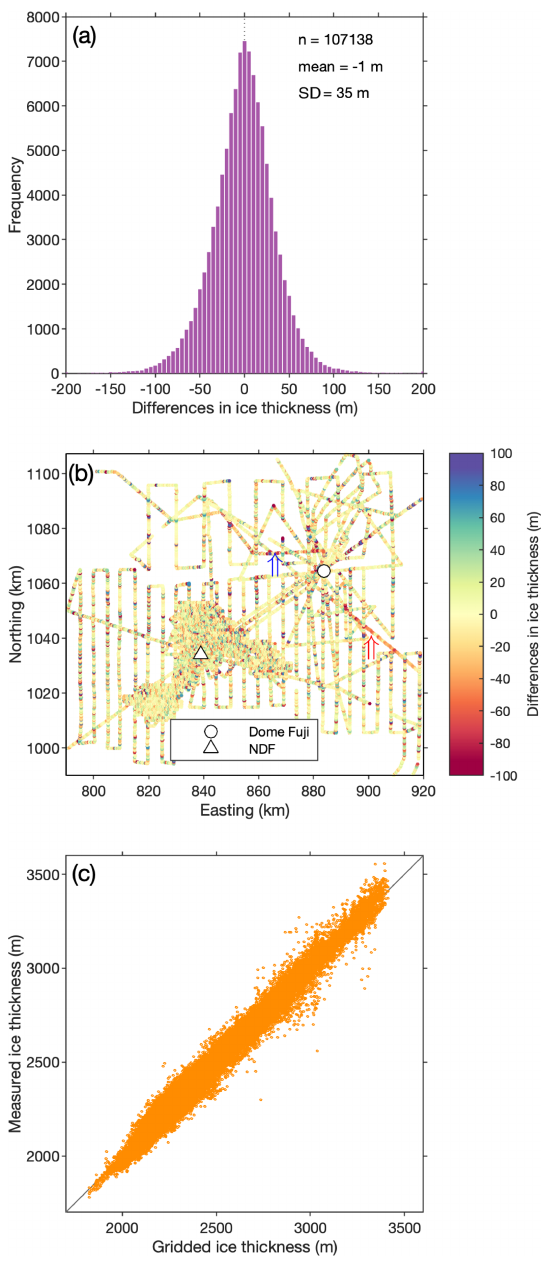
Figure 5. (a) Histogram and (b) spatial distribution showing dif- ferences in ice thickness between point measurements and 0.5km gridded data. Red and blue arrows in (b) indicate the radar lines of JARE37 and JARE49. (c) Scatter plot showing the gridded ice thickness against the point measurement